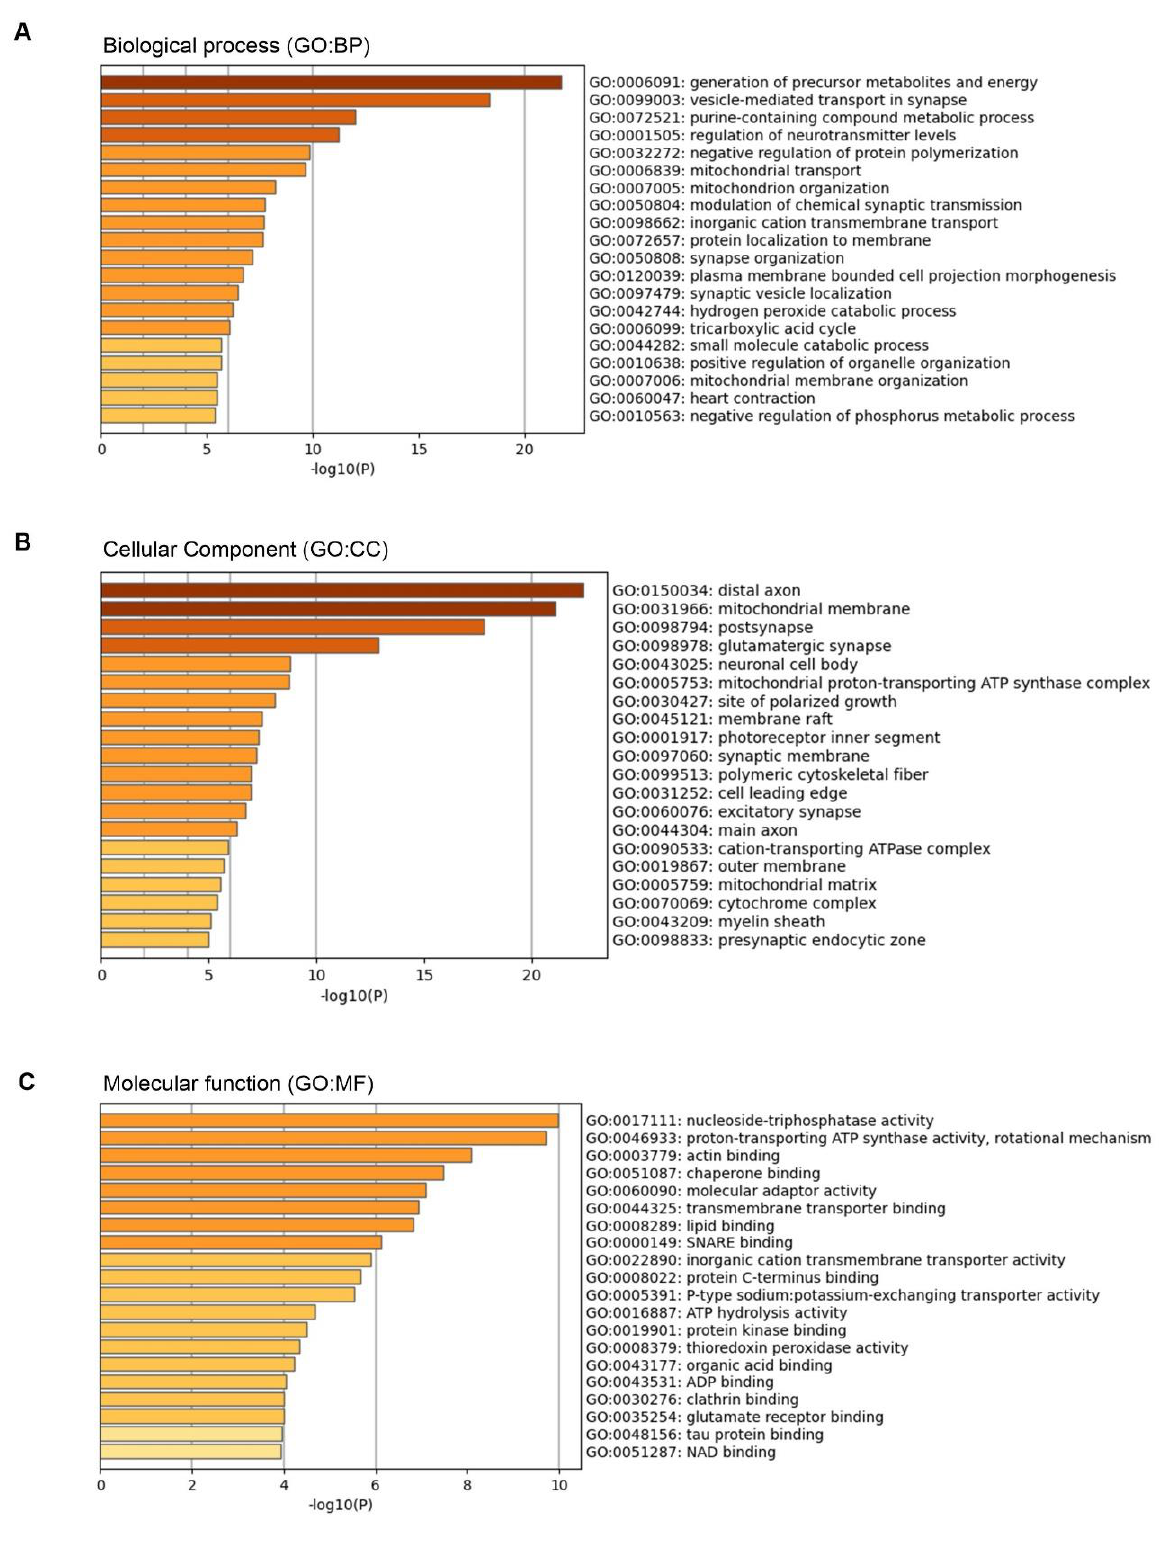
Figure 2. Summary of significantly enriched ( p < 0.05) biological processes (GO:BP) ( A ), cellular components (GO:CC) ( B ), and molecular functions (GO:MF) ( C ) connected with all identified proteins – results from Metascape (A Gene Annotation and Analysis Resource).